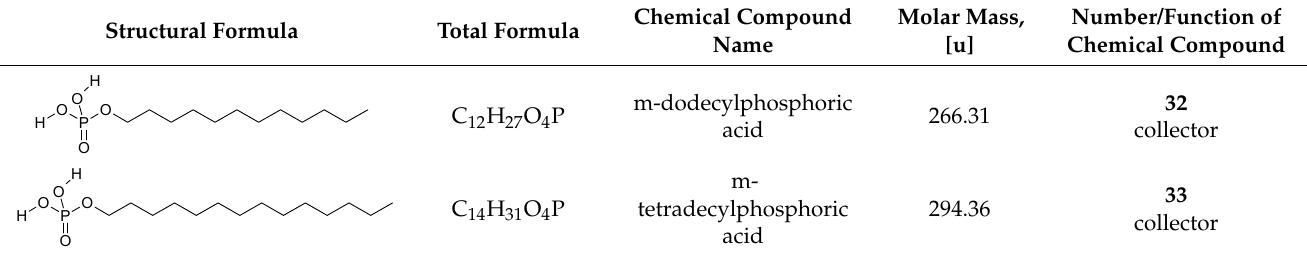
Table 3. Characteristics of organic acids used for research as collectors for the process of ionic flotation. Structural Formula